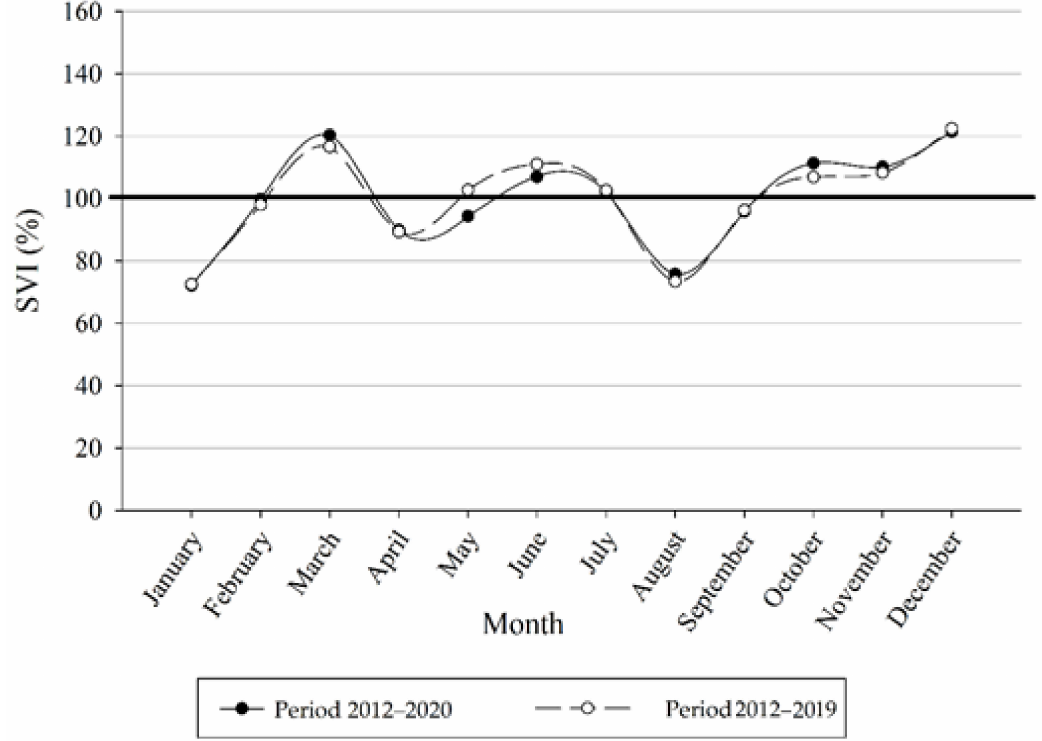
Figure 21. Seasonality pattern of vehicle disembarking traffic of the port of Vigo during the periods 2012–2019 and